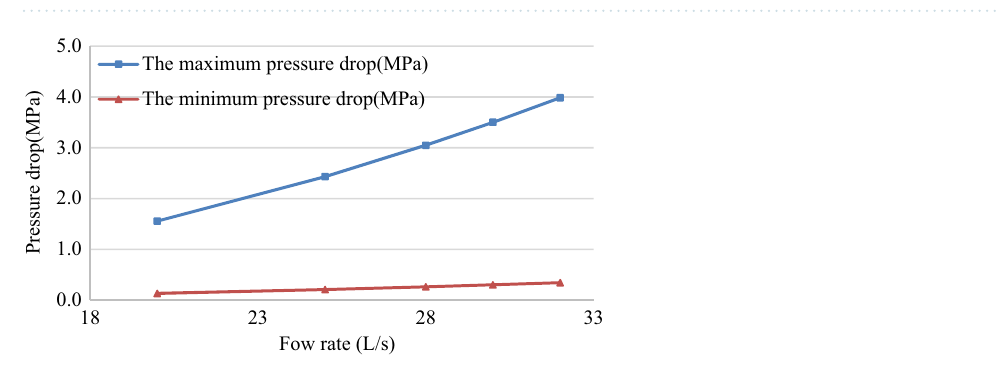
Figure 7. Relationship between pressure drop and flow rate.